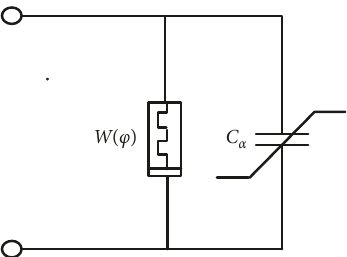
Figure 2: Equivalent circuit model of the memristor affected by the parasitic fractional inductor.